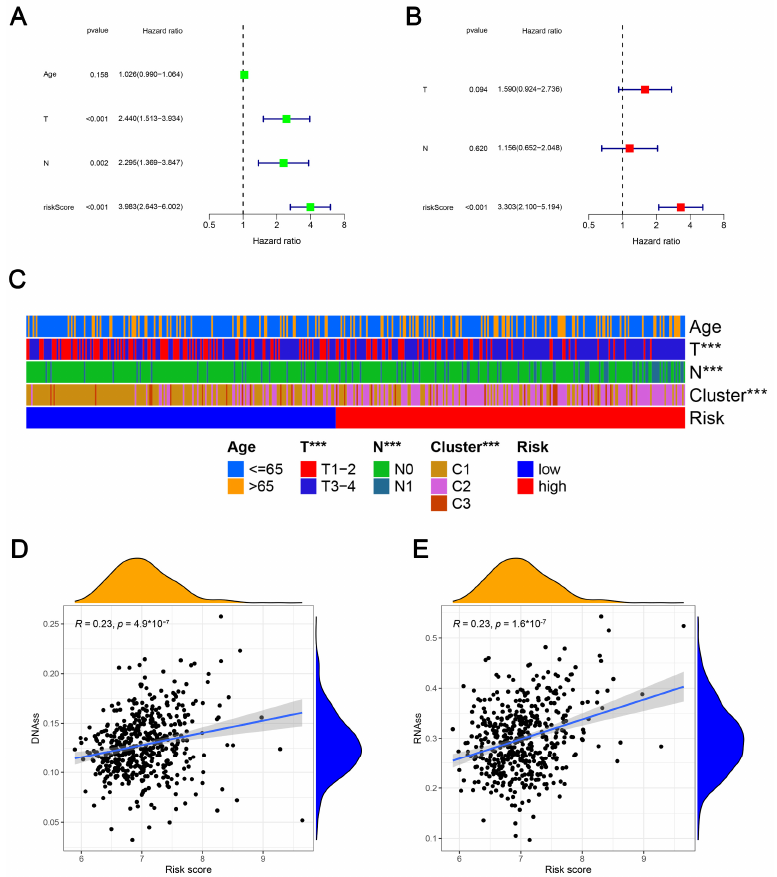
Figure 6. Univariate and multivariate independent prognostic analysis ( A , B ). Association of the LLPS-related signature with clinical characteristics ( C ), DNAss stemness score ( D ), RNAss stemness score ( E ). ***: p < 0.001.